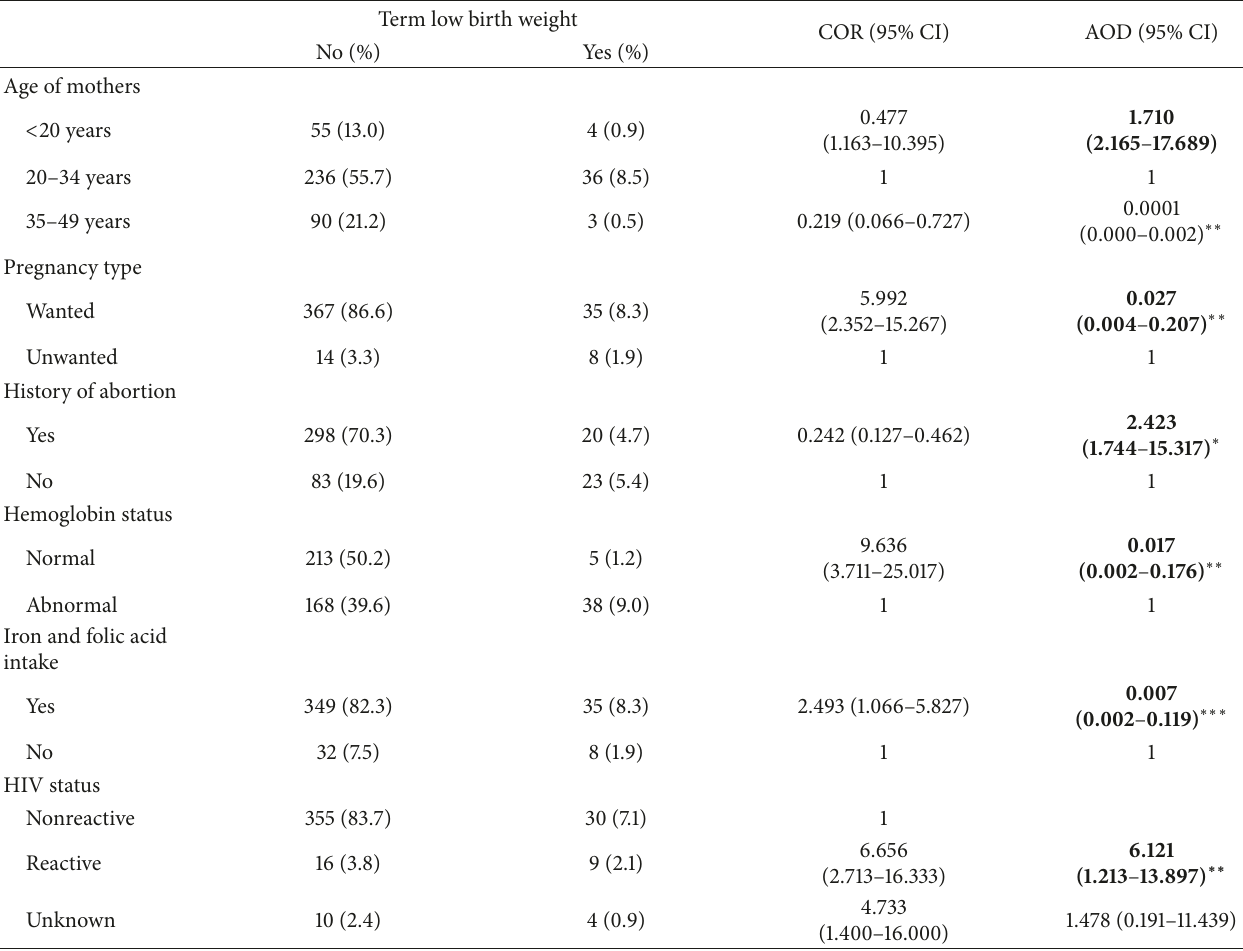
Table 4: Multivariable analysis of mothers data from July 1, 2014, to June 30,